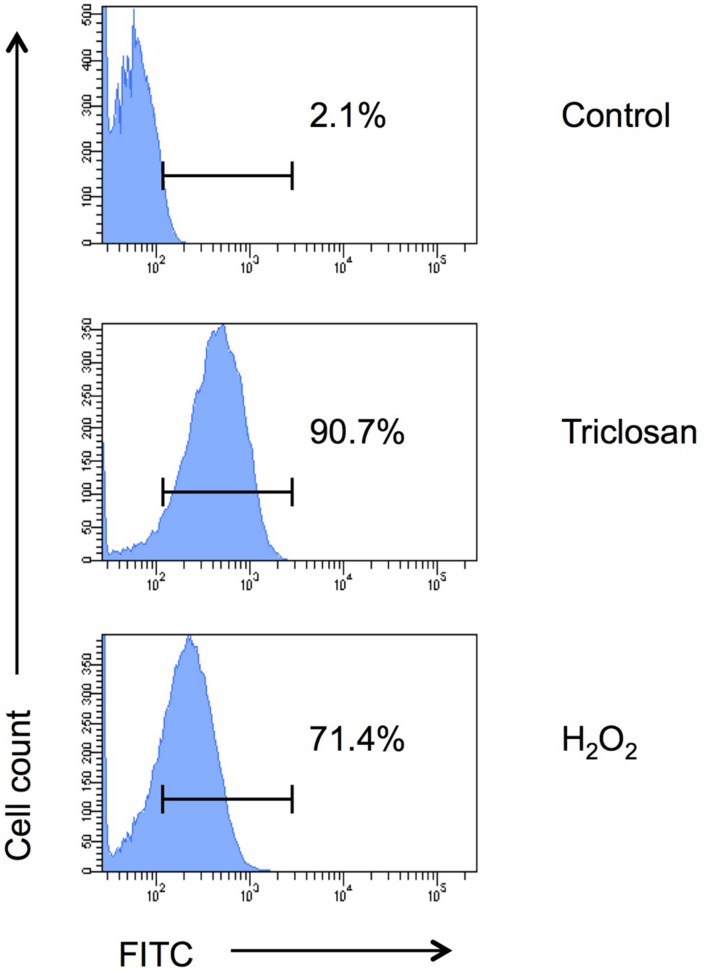
TUNEL assay. Apoptosis of triclosan-treated C. neoformans H99 cells was determined by TUNEL assay followed by flow cytometry analysis. C. neoformans H99 cells were non-treated (control), treated with triclosan (0.5 μg/ml) or H2O2 (2 mM) for 4 h. Percentages of the apoptotic cells were indicated. Data shown are representative of two independent experiments.